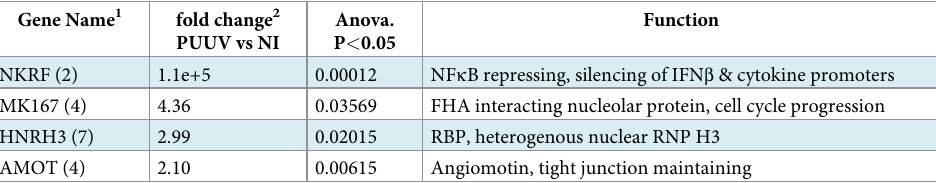
Table 2. Human proteins found in complex with PUUV-N in HEK293T